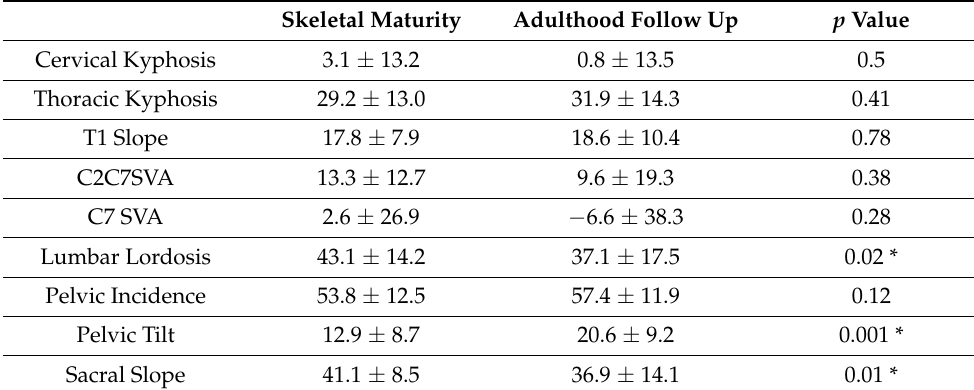
Table 3. Comparison of sagittal measurements between skeletal maturity and at final follow